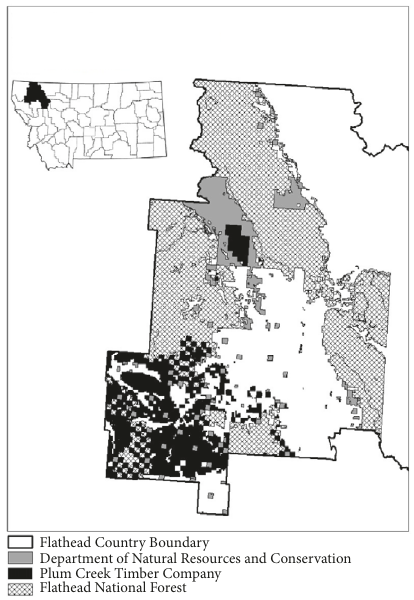
Figure 1: Location of three forests in Flathead County, Montana,